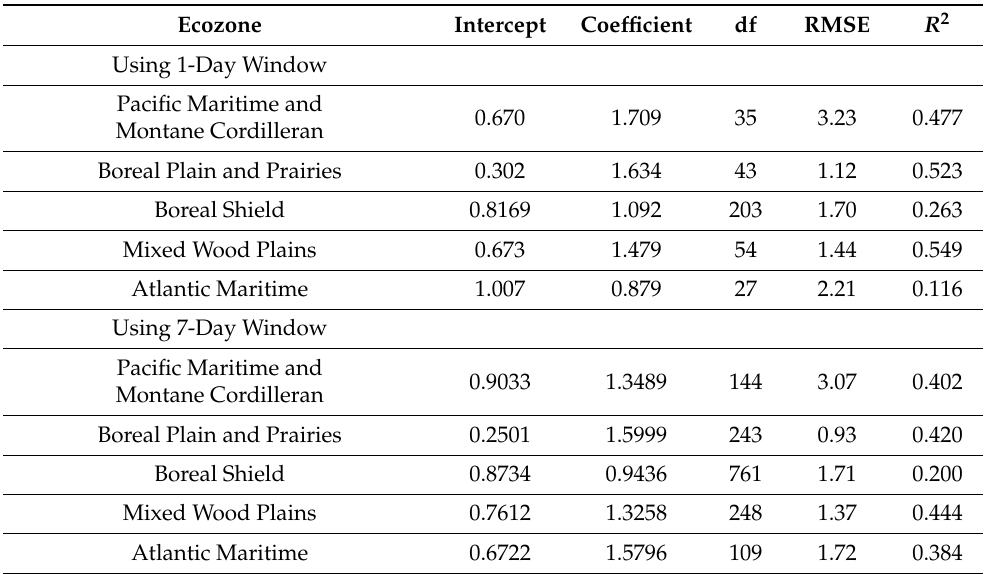
Table 2. Regression models estimating in situ SDD from Landsat 8 Blue/Red surface reflectance for different ecozones or ecozone groupings in the southern half of Canada. (df = degree of freedom; RMSE = root mean square error). Ecozone Intercept Coefficient df RMSE R 2 Using 1-Day Window Pacific Maritime and Montane Cordilleran